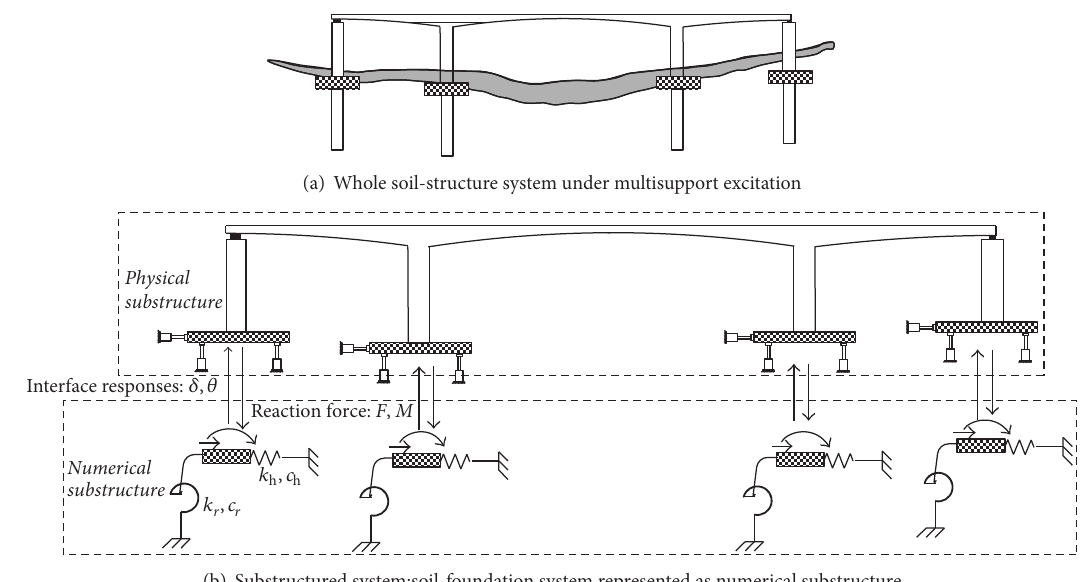
Figure 2: Substructuring system for bridge subject to earthquake excitation.